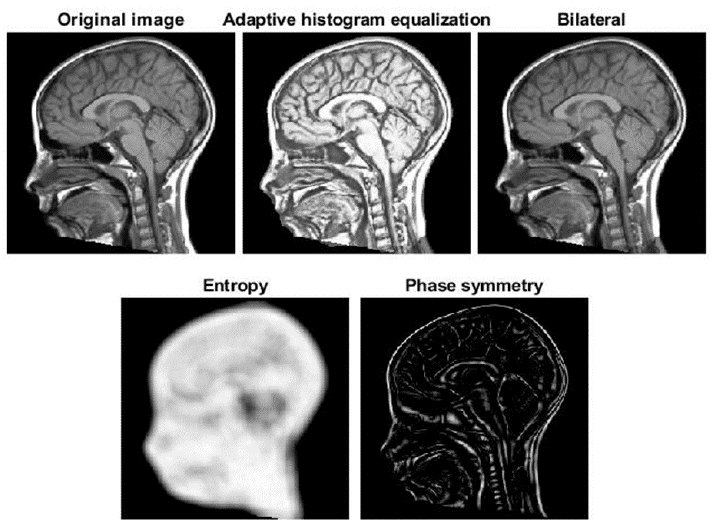
Figure 3. The five images used for the multi-image demons registration of an example sagittal